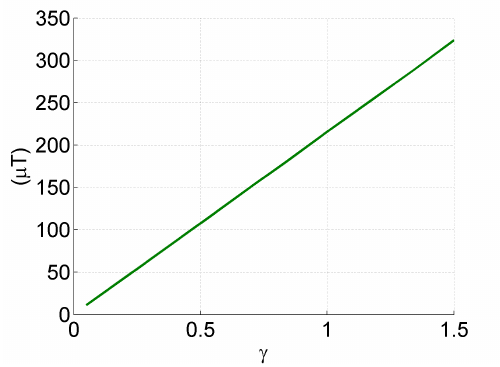
Figure A3. Mean magnetic flux density in the ferrite versus the scaling